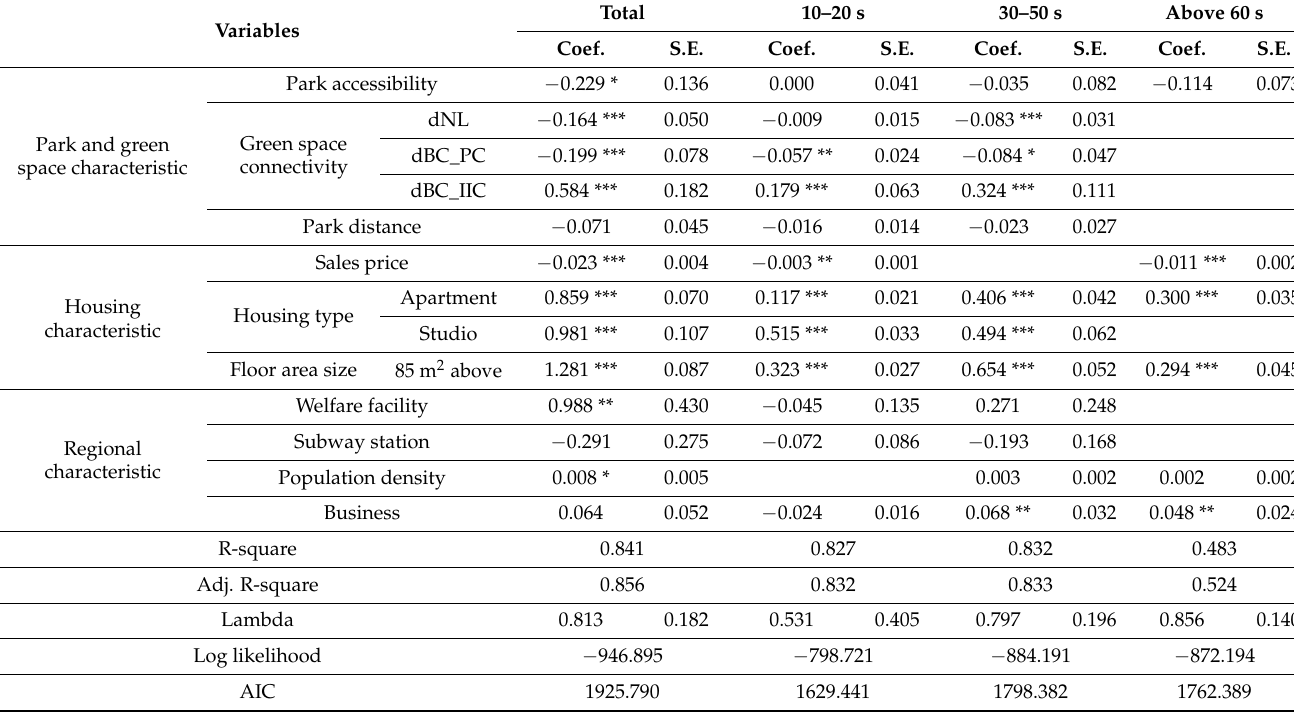
Table 4. SEM Results for Single-person Households by Age